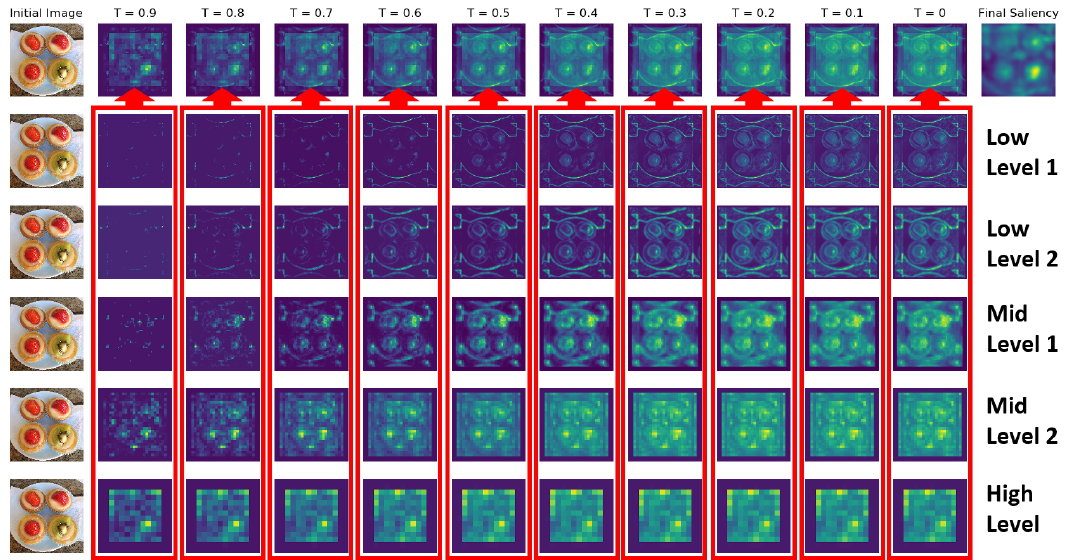
Figure 5. Detailed maps of different levels (from Low Level 1 to High Level) and different thresholds on feature rarity (from 0.9 to no threshold) within the VGG16